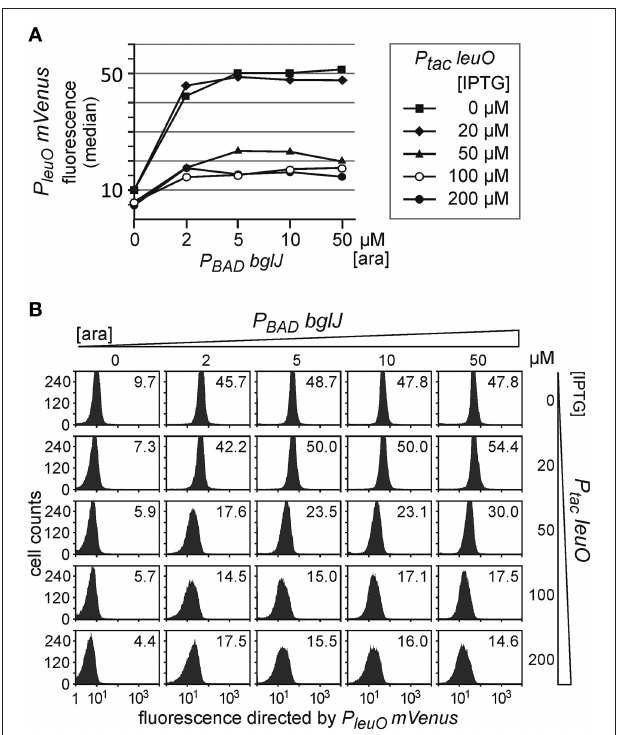
FIGURE 4 | Antagonistic regulation of P leuO mVenus transcription by BglJ-RcsB and LeuO. Fluorescence of transformants of P leuO mVenus strain U69 with plasmids pKES302 ( P BAD bglJ ) and pKEHB27 ( P tac leuO ) was monitored by flow cytometry. (A) The median fluorescence is plotted against the arabinose concentration used for induction of bglJ . Each line graph represents the set of data obtained of cultures grown with the specified IPTG concentration used for induction of leuO . (B) Flow cytometry data of cultures grown with increasing arabinose (rows) and IPTG (columns) concentration. Plotted in each panel are the cell counts against the fluorescence intensity. The fluorescence distribution in each panel is in agreement with uniform expression within the population. The fluorescence median that is plotted in (A) is given within each panel. Cultures were inoculated from overnight cultures to an OD 600 of 0.05 and grown for 5h in 10ml tryptone medium containing ampicillin, chloramphenicol, as well as IPTG and arabinose at the indicated concentrations.